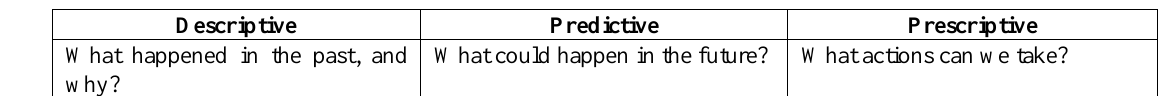
Table 1. Types of